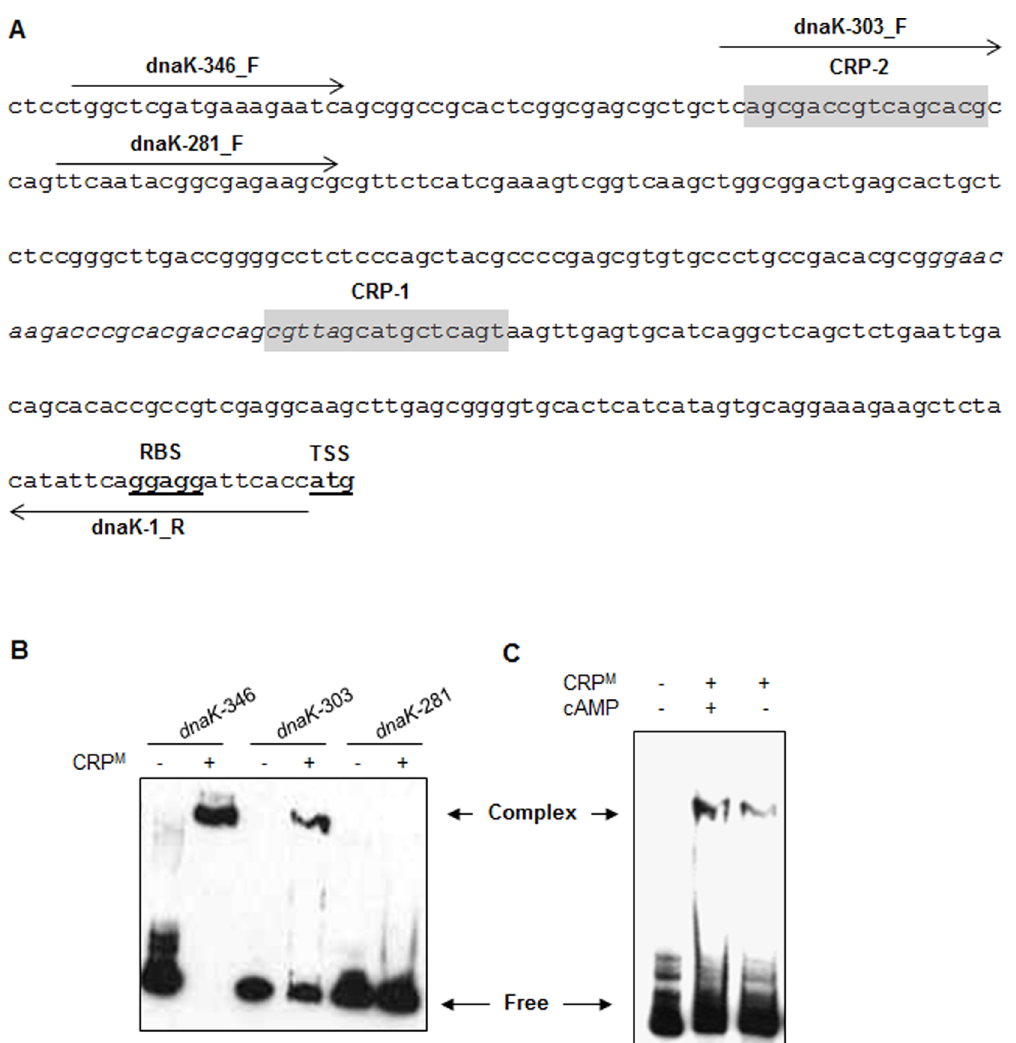
Figure 4. Identification of CRP-binding motif in promoter region of dnaK operon by EMSA. A) Sequence of the 5’-UTR of dnaK operon. The putative ribosome-binding site (RBS), and the translation start site (TSS) are boldfaced and underlined. The putative CRP-binding sites are shaded, whereas the SigH-recognition sequence is shown in italics. Positions and directions of the primers that were used for PCR amplification of DNA fragments shown in (B) are marked by horizontal arrows. B) Interaction of CRP M with the 5’-UTR of dnaK operon. Biotin-labeled dnaK promoter fragments of various lengths, as shown, were incubated with CRP M in the presence of 1 mM cAMP before separation of DNA-protein complexes by gel electrophoresis. Reaction mixtures containing promoter fragments but lacking the CRP M were resolved in adjacent lanes as controls. C) Effect of cAMP on complex formation between CRP M and dnaK promoter. Purified CRP M pre-incubated with or without 1 mM cAMP for 30 min on ice, was subject to binding with full length dnaK promoter fragment ( dnaK -346) for 15 min at 37 u C before separation of CRP M – dnaK complexes by gel electrophoresis. Complex, CRP M – dnaK complex; Free, unbound DNA fragment. doi:10.1371/journal.pone.0089759.g004 Table 3. Identification of putative SigH-recognition sequences in the 5’-UTRs of AC-encoding genes of Mtb.